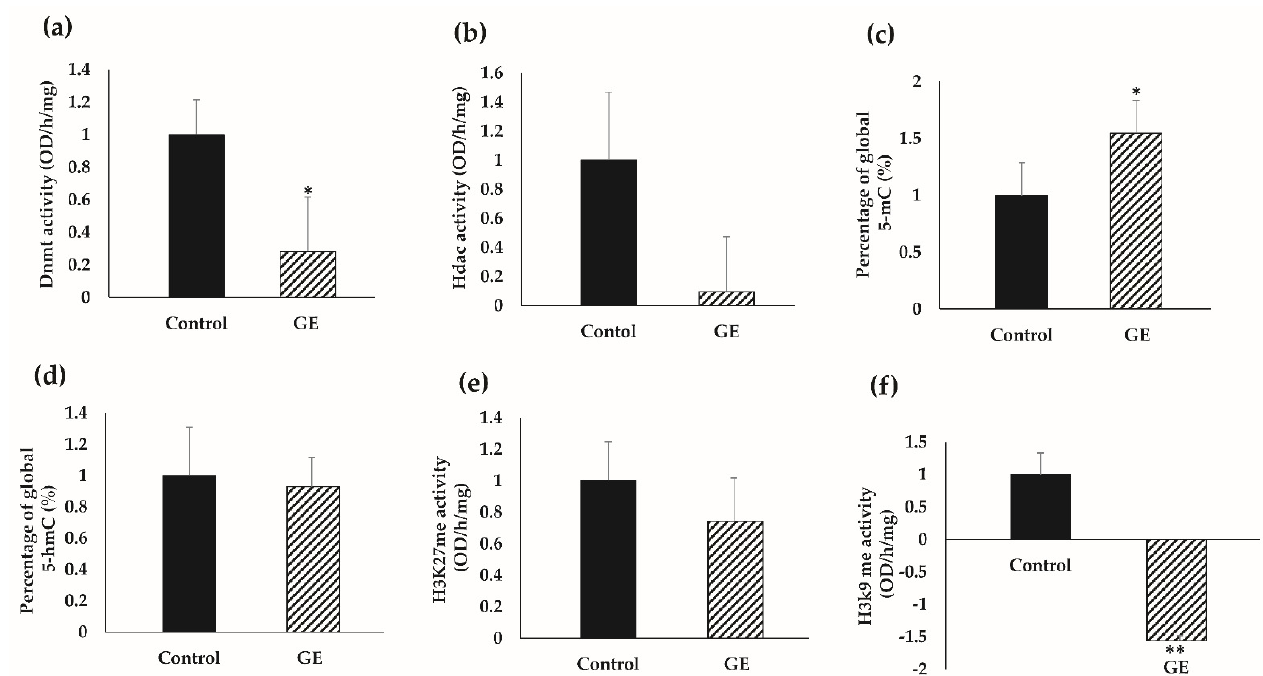
Figure 6. Global epigenetic profiles in response to GE treatment. ( a ) Dnmt activity. ( b ) Hdac activity. ( c ) Global DNA methylation levels as represented global 5-mC percentage in genomic DNA. ( d ) Global DNA hydroxymethylation levels as represented genomic 5-hmC content in total DNA. ( e ) Histone methyltransferase (H3K27) activity. ( f ) Histone methyltransferase (H3K9) activity. Results were in triplicate from three randomly selected mouse TNBC tumors from each treatment group. Columns, mean; bars, SE; ** p < 0.001, * p < 0.05, significantly different from the control group. GE, genistein